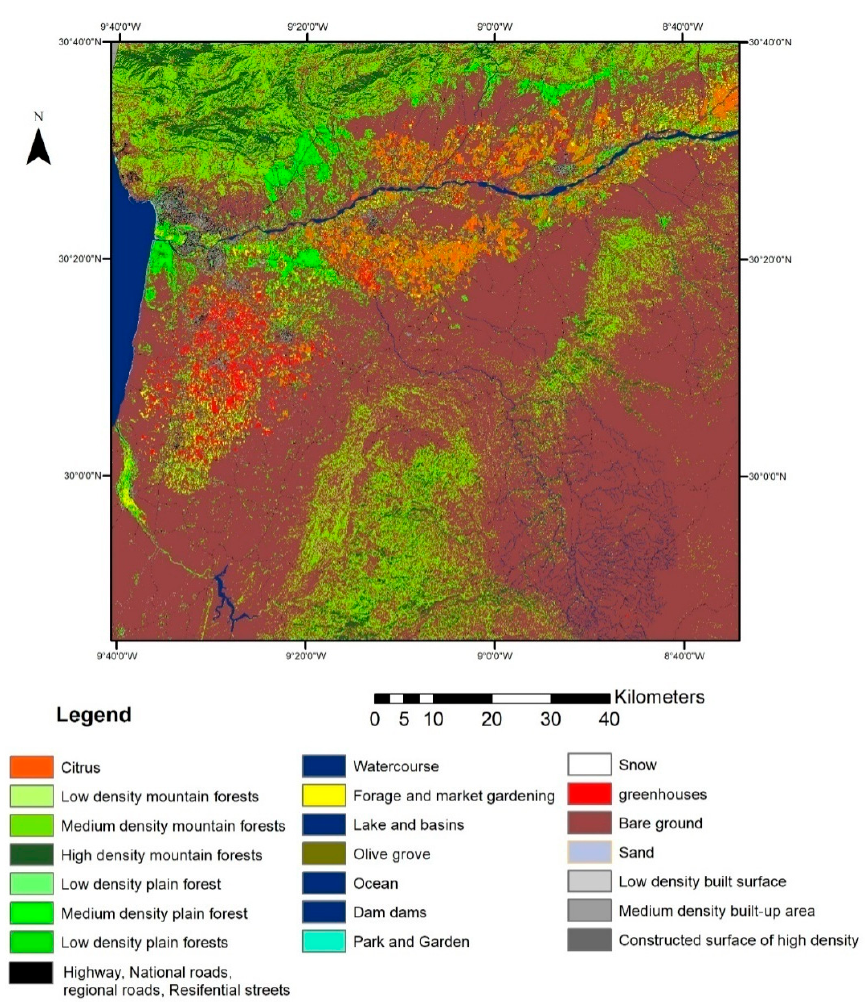
Figure A2. Land use / land cover obtained using satellite images (Sentinel 2A, Figure A2. Land use/land cover obtained using satellite images (Sentinel 2A, R10m).